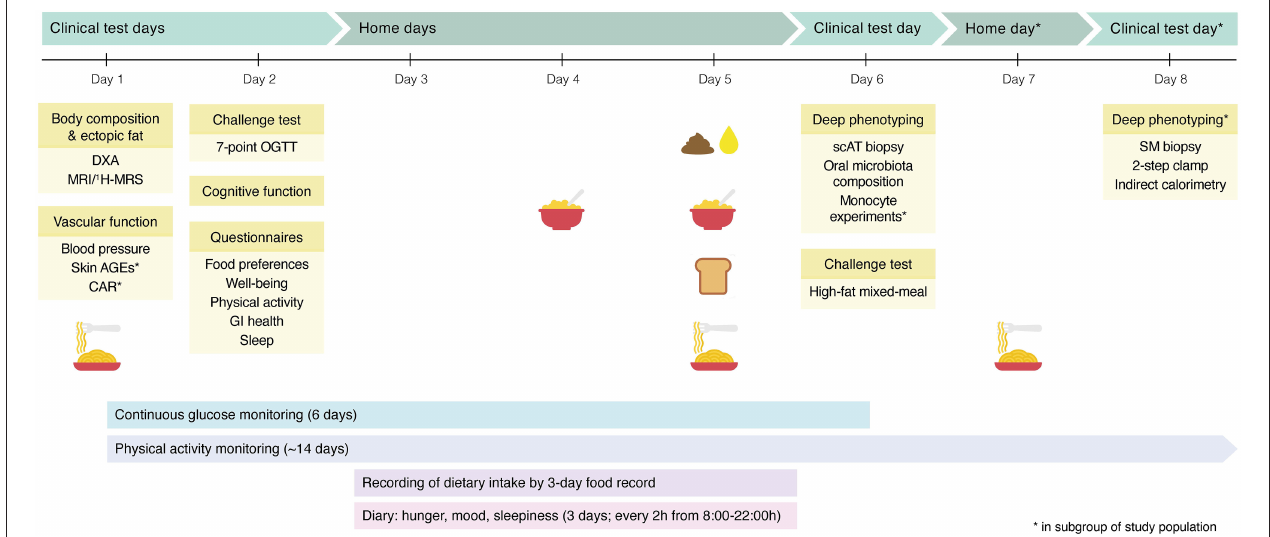
FIGURE 2 | Graphical overview of the pre- and post-intervention characterization week. The characterization week contains multiple clinical test days, during which participants are extensively phenotyped. In addition, blood glucose and physical activity are continuously monitored. At home, participants record their dietary intake and feelings of well-being, collect a fecal sample and 24-h urine, and consume a standardized breakfast on day 4, and on day 5, participants have a full day of standardized meals and snacks, including the standardized breakfast. In a subgroup of the study population, additional measurements are performed. DXA, dual-energy X-ray absorptiometry; MRI, magnetic resonance imaging; 1 H-MRS, proton magnetic resonance spectroscopy; AGEs, advanced glycation endproducts; CAR, carotid artery reactivity; OGTT, oral glucose tolerance test; GI, gastrointestinal; scAT, subcutaneous adipose tissue; SM, skeletal